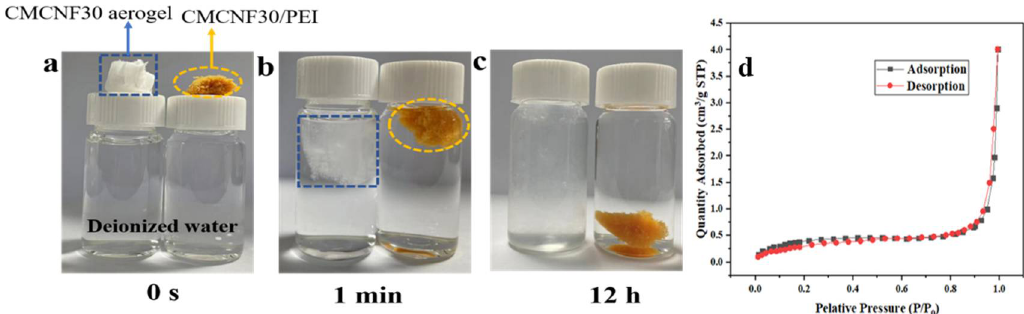
Figure 3. CMCNF30 and CMCNF30/PEI aerogel in deionized water for ( a ) 0 s, ( b ) 1 min, ( c ) 12 h; ( d ) adsorption–desorption isotherm of CMCNF30-PEI aerogel at 77K.